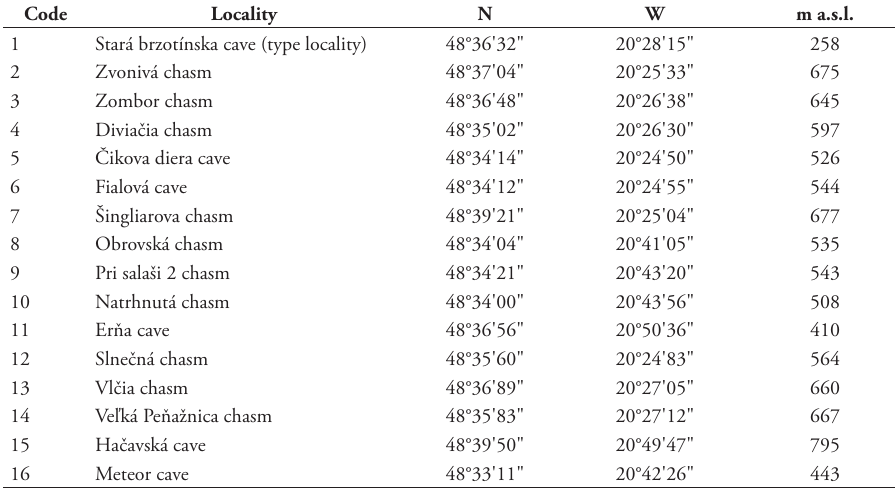
Table 1. List of collection localities of Neobisium slovacum in the Slovak Karst area (1–15 Slovakia; 16 Hungary). Abbreviations: a.s.l., above sea level; N, latitude; W, longitude (see map, Fig.